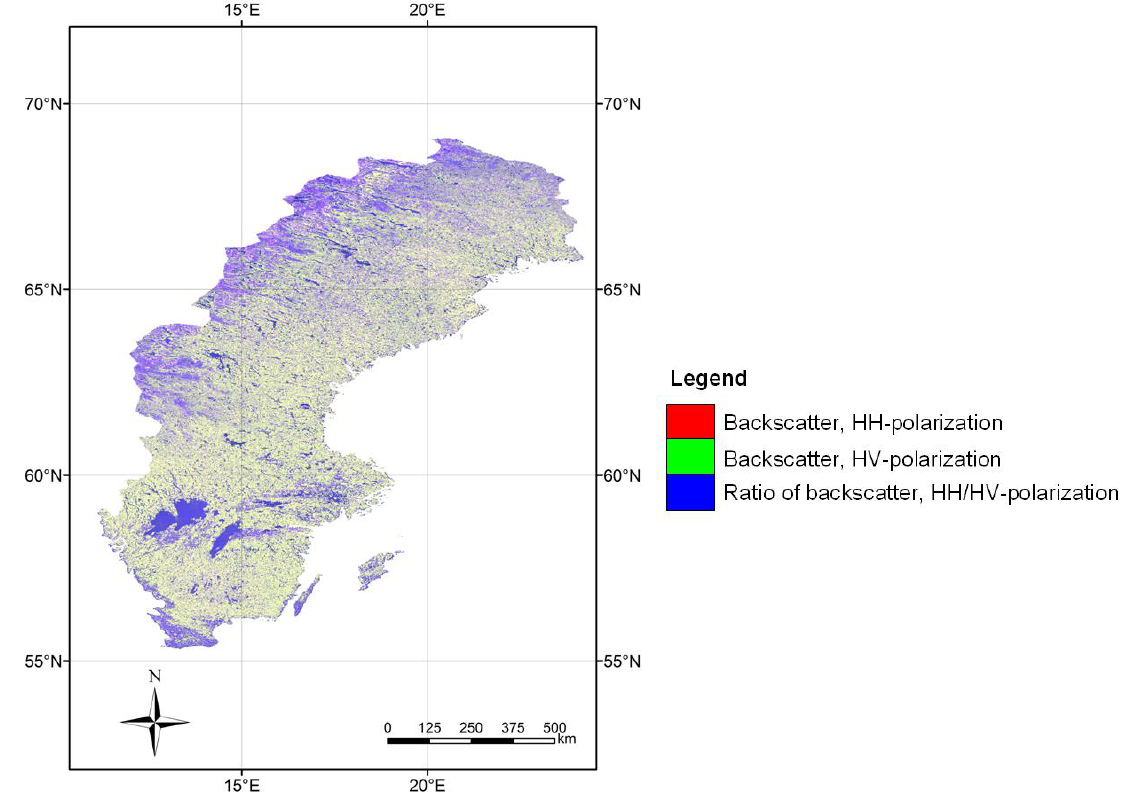
Figure 1. Mosaic of ALOS PALSAR K&C strip images acquired in Fine Beam Dual (FBD) mode during 2009 over